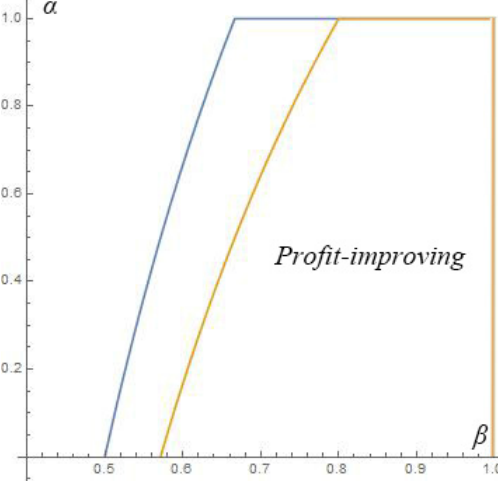
Figure 1. The region of privately beneficial CSR in the global economy.